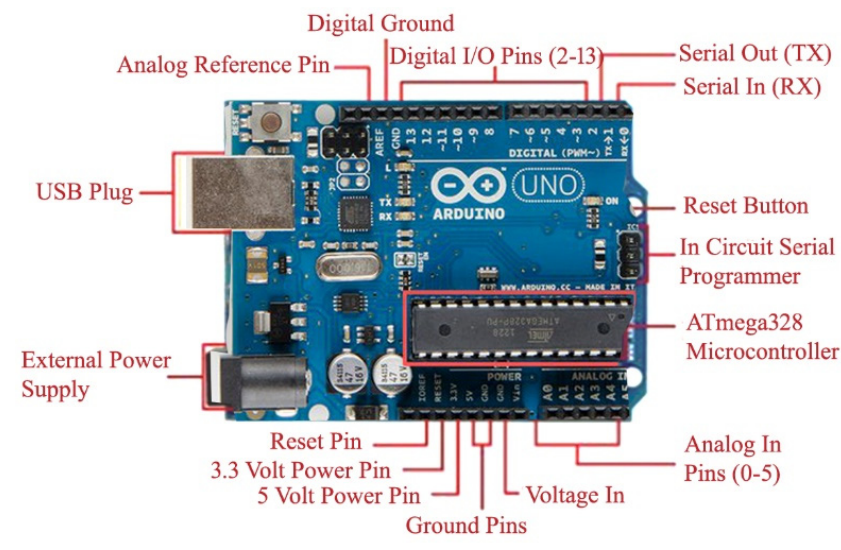
Figure 4. Arduino Uno R3 pin descriptions [55].